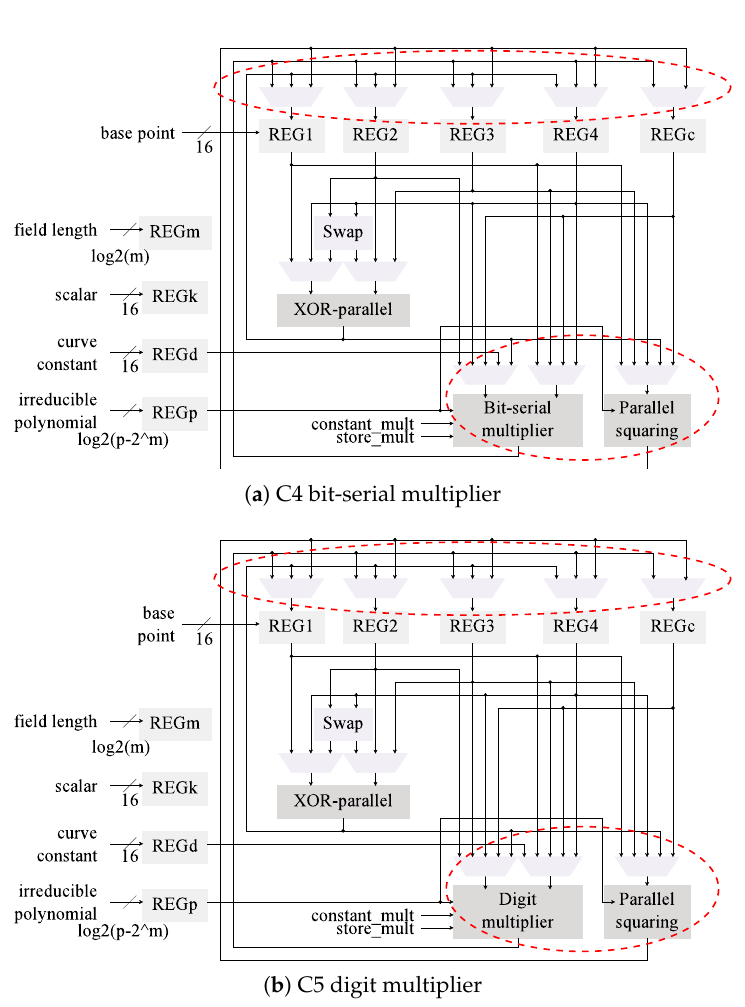
Figure 5. Architectures for kP featuring dedicated squaring